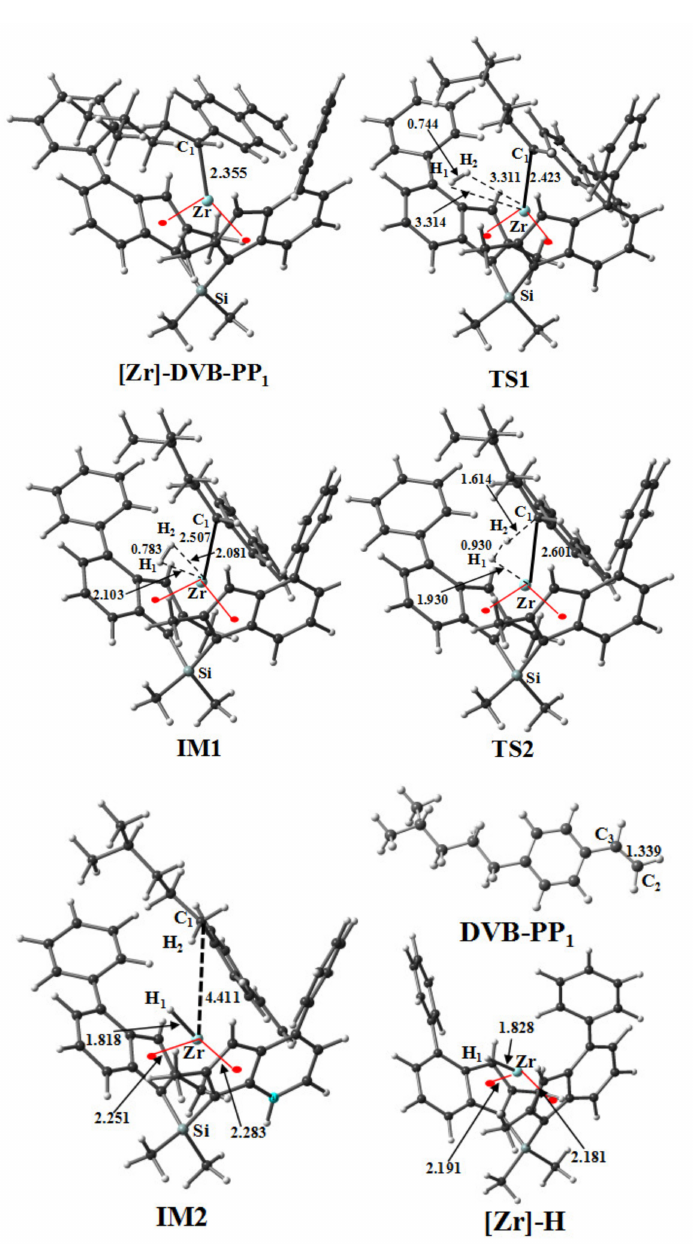
Figure 3. Optimized structures of key transition states (TSs) and intermediates (IMs) in the DVB reaction pathway shown in Figure 2. The key length is in